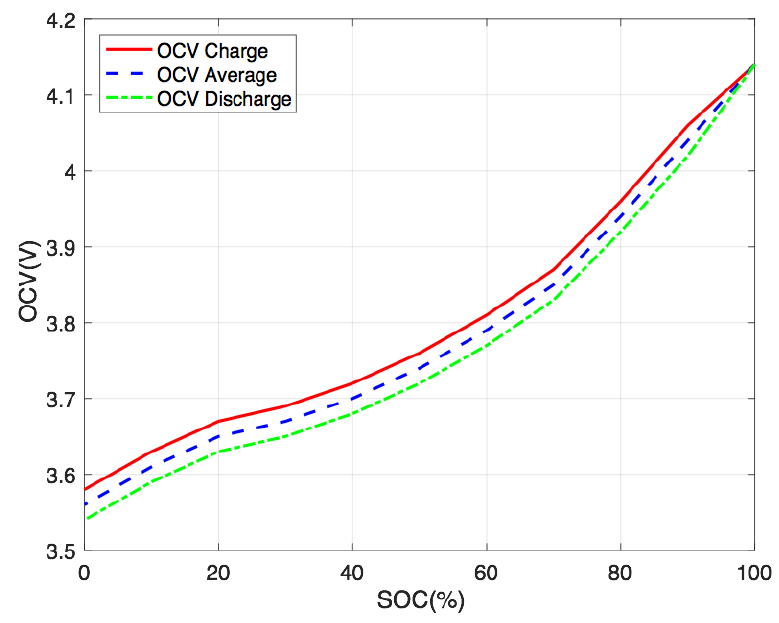
Figure 11. SOC-OCV curves under the charge and discharge process.